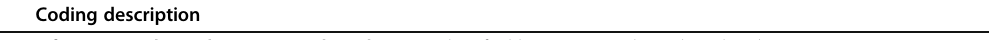
Table 1 Descriptive codes assigned to unit plans Dimension Coding